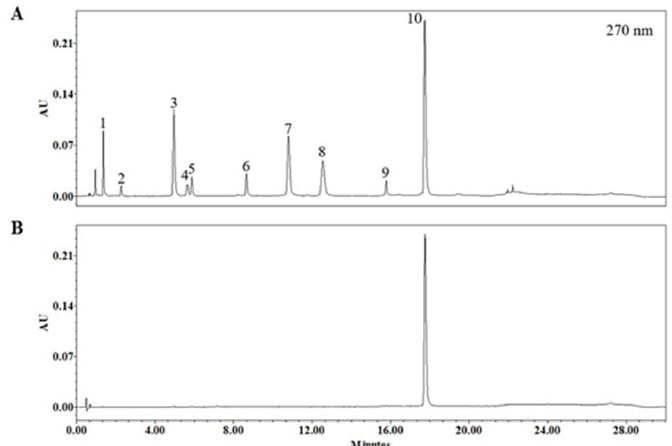
Figure 1. Ultra-performance liquid chromatography (UPLC) chromatogram of Acer tataricum subsp. ginnala extract ( A ) and reference standards solution ginnalin A ( B ). Among the 10 identified peaks, peak no. 10 was identified as ginnalin A. Detailed information of the other peaks are listed in Table 1. Table 1. Retention time (Rt), UV λ max, chemical formula, theoretical mass, measured mass, mass difference, and identification of UPLC peaks.